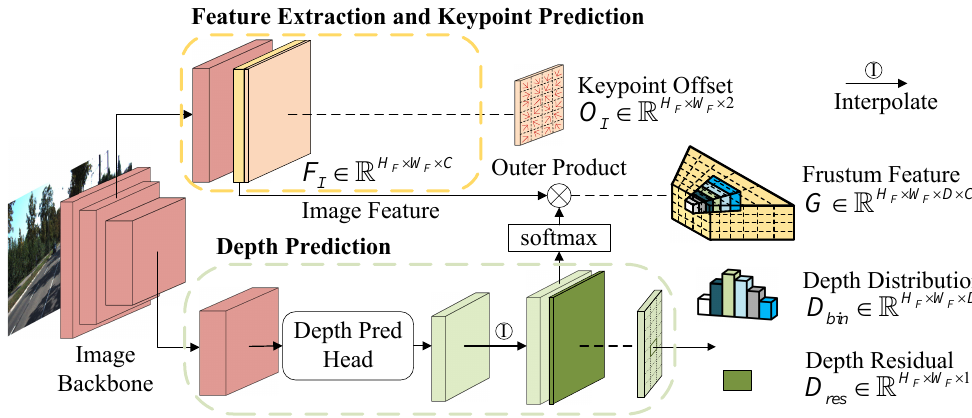
Figure 3. Illustration of Frustum Feature